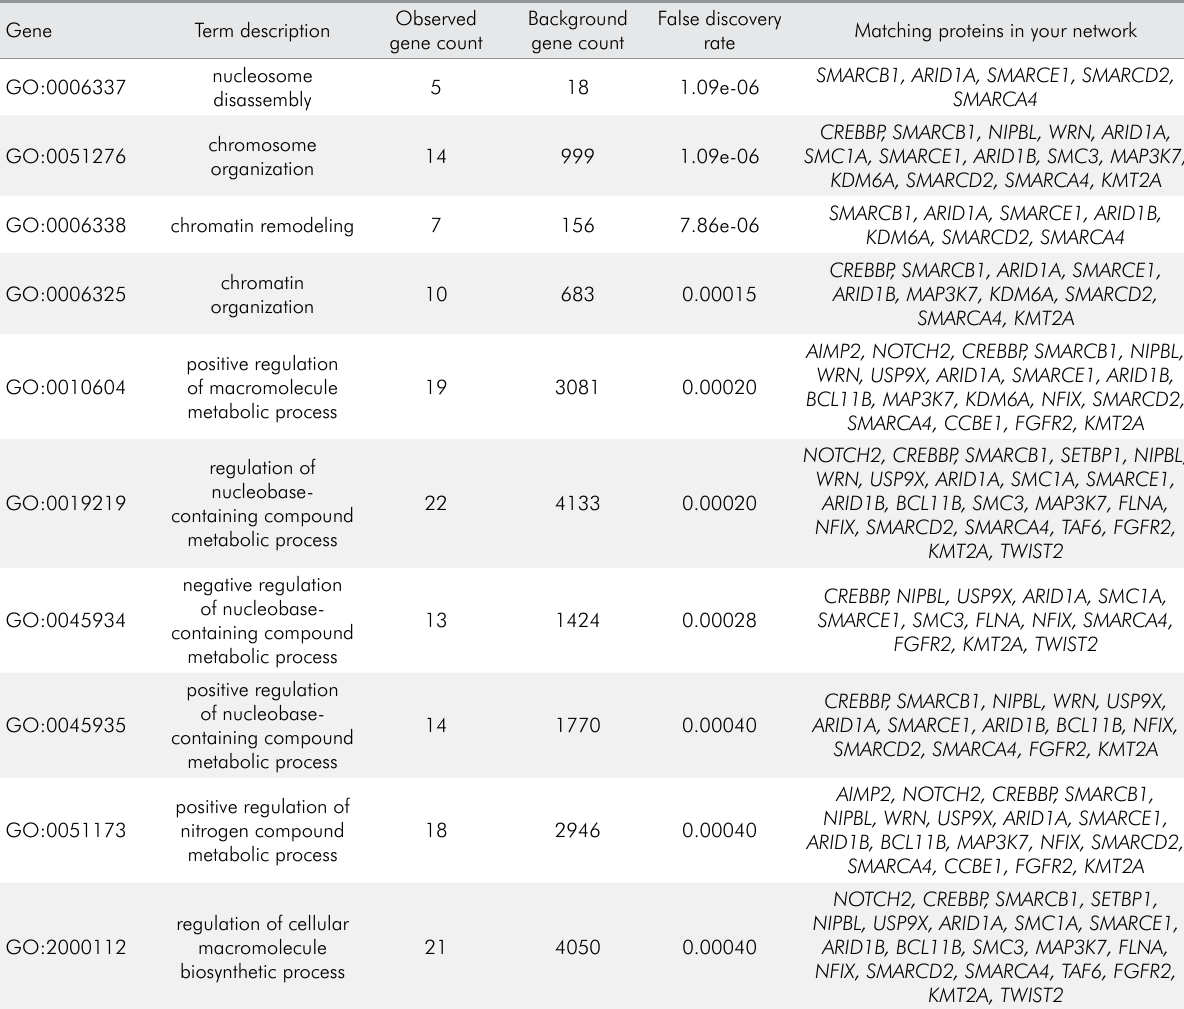
Table 3. Main biological processes characterized with the list of altered genes in syndromes with hypertrichosis and dental anomalies. Gene